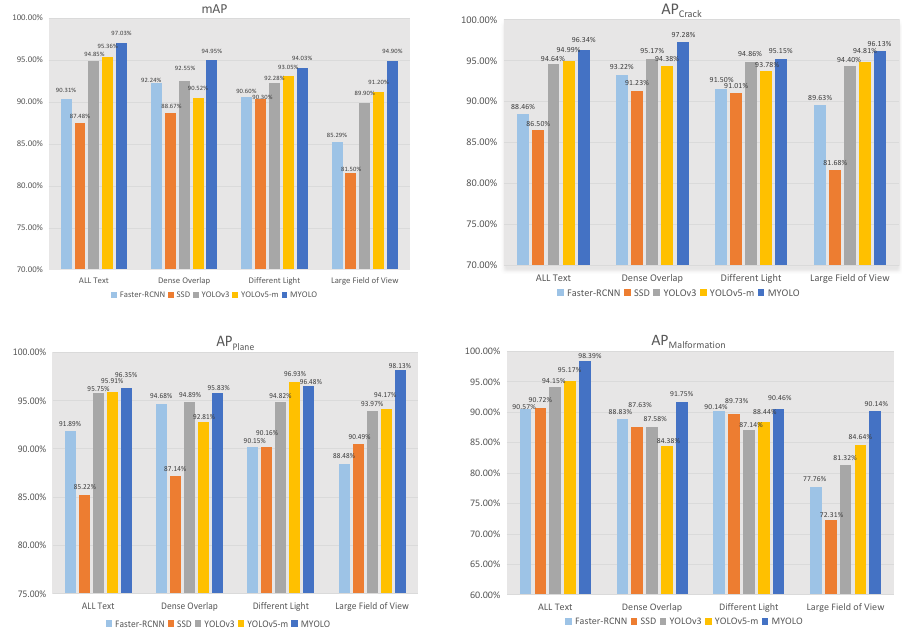
Figure 14. Detection results for each algorithm in different scenarios (IoU threshold set to